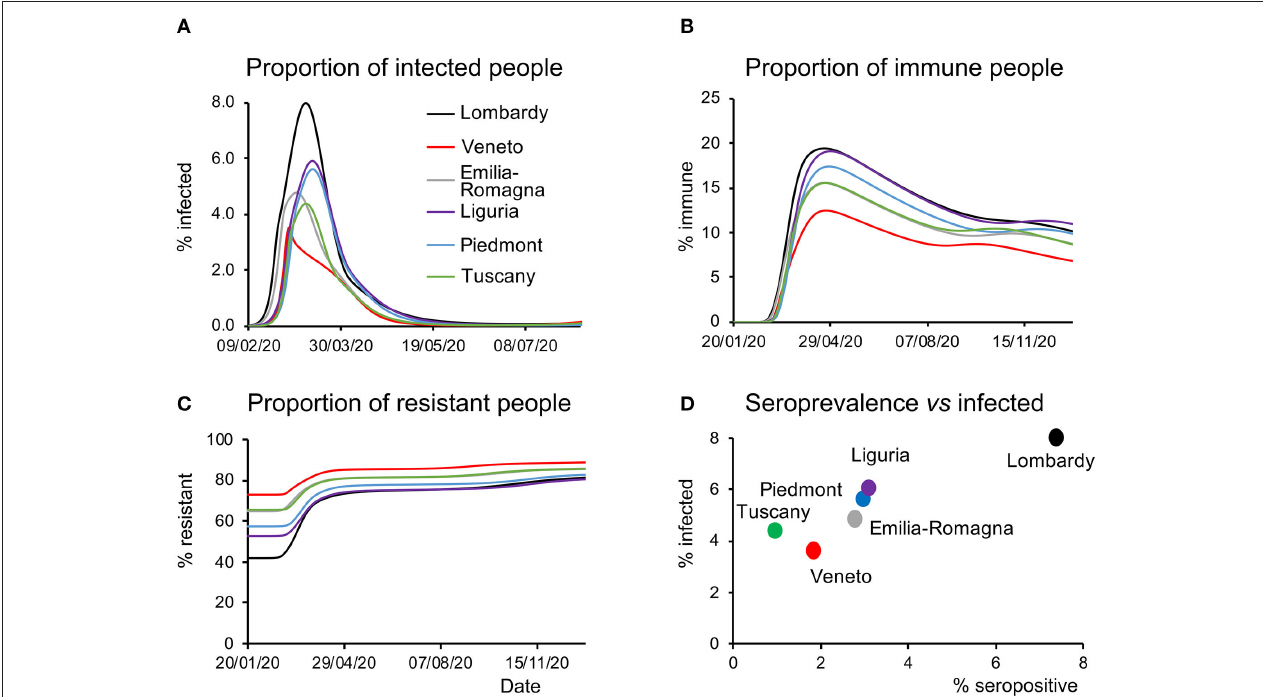
FIGURE 3 | Latent causes. (A) Time course of the proportion of infected people during the epidemic and in the following months for all the regions considered. Note that Veneto shows a steep rise at the beginning of the epidemic but quickly drops to the initial values, whereas other regions display slower kinetics. (B) Time course of the proportion of immune people during the epidemic and in the subsequent months for all the regions considered. As in the case of infected people, this proportion is the lowest in Veneto throughout most of the considered time window. (C) Time course of the proportion of resistant people during the epidemic and in the subsequent months for all the regions considered. Notice how at the beginning of the epidemic this proportion was highest in Veneto. (D) Data on the serological test (% of the population that have been infected) are plotted against the peak value of the proportion of infected people inferred by the model and shown in (A)